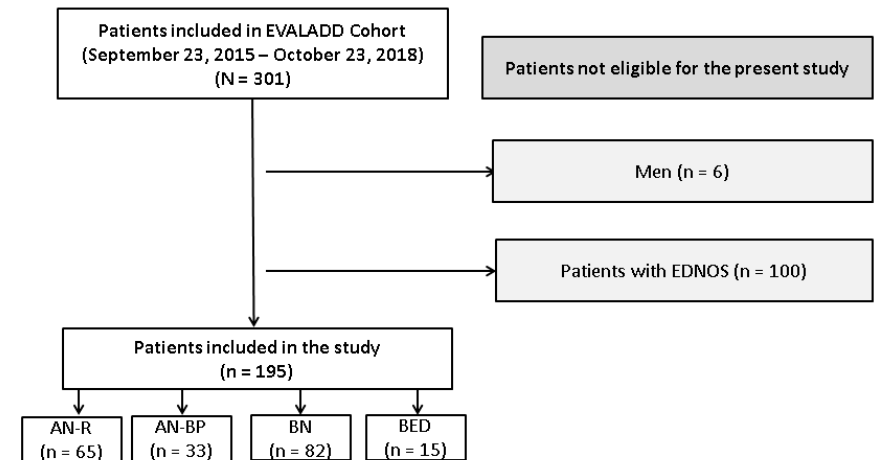
Figure 1. Flow chart of patient selection. AN-R: anorexia nervosa restricting type; AN-BP: anorexia nervosa binge eating / purging type; BN: bulimia nervosa; BED: binge-eating disorder; EDNOS: eating disorders not otherwise specified; n : number of patients included or excluded at each step of the inclusion